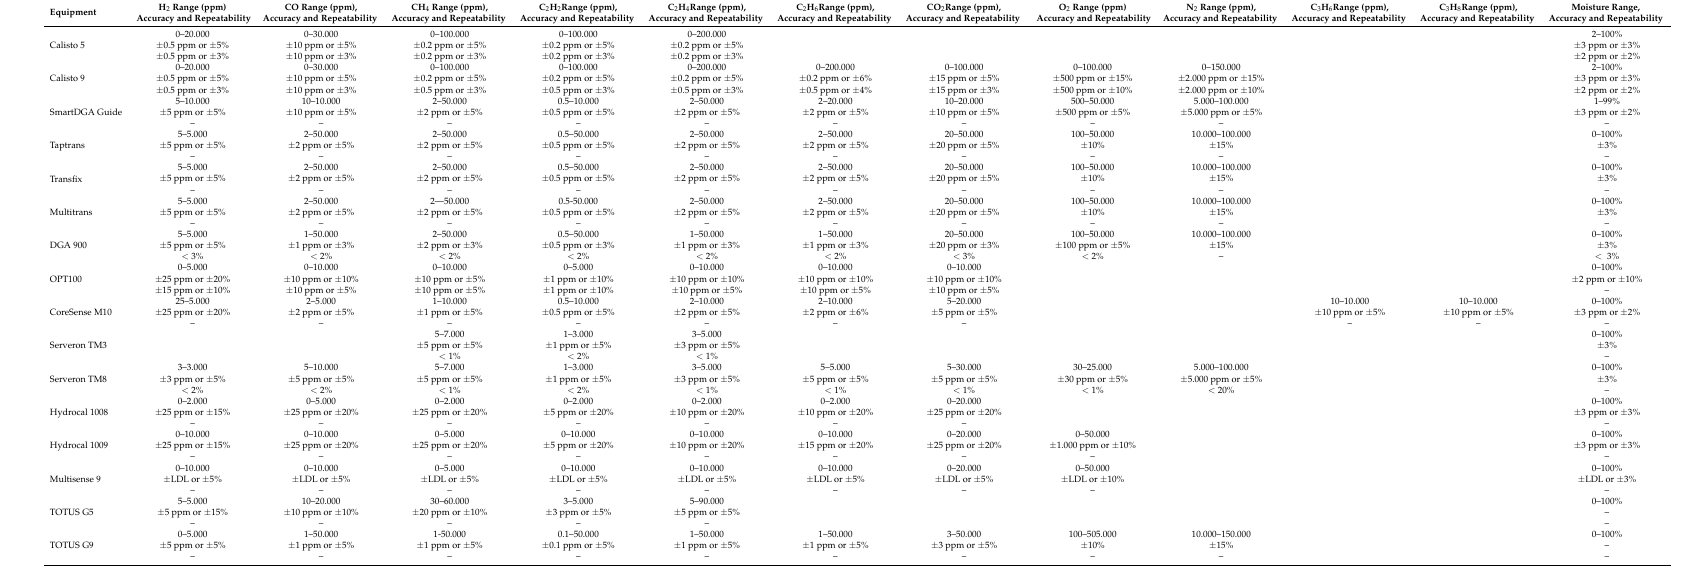
Table 11. Gas concentration and moisture measurements range, accuracy and repeatability of the fault diagnosis monitors (as indicated by the